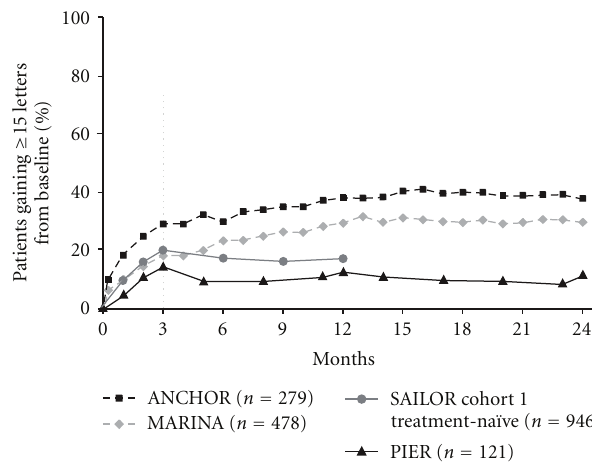
Figure 5: Percentage of patients with 20/40 or better vision over time among pooled ranibizumab-treated patients by clinical trial. Dosing: ANCHOR and MARINA, monthly; PIER, months 0, 1, 2, 5, 8, 11, 14, 17, 20, and 23; SAILOR, months 0, 1, and 2, then as needed. Vertical line indicates switch from monthly to quarterly and as-needed dosing in PIER and SAILOR, respectively. ANCHOR: n = 279 at month 0; SAILOR cohort 1 treatment-na¨ıve: n = 946 at month 0.